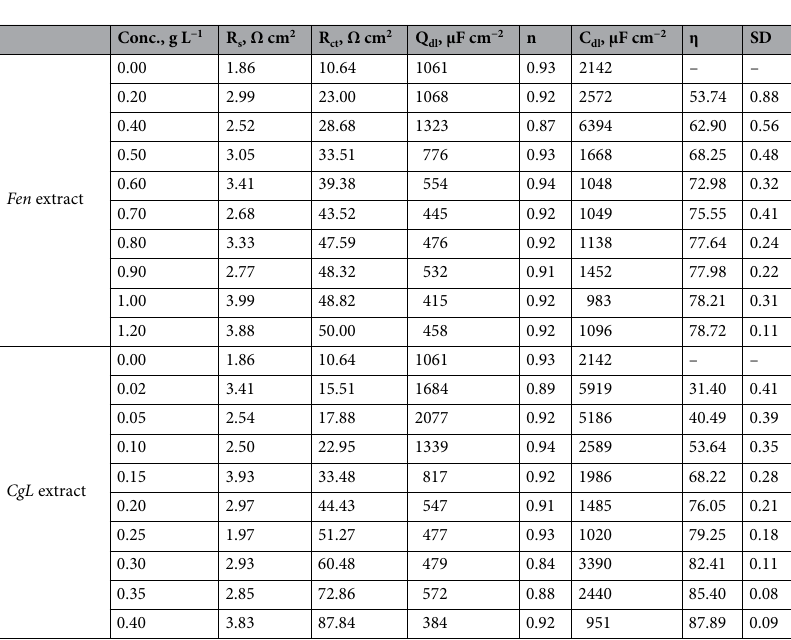
Table 3. Electrochemical impedance parameters of steel in 20% phosphoric acid in the absence and presence of Fen and CgL